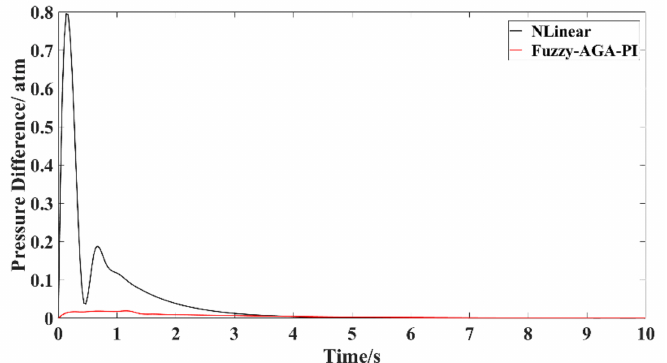
Figure 8. Variations in pressure di ff erence when the PEMFC operation is